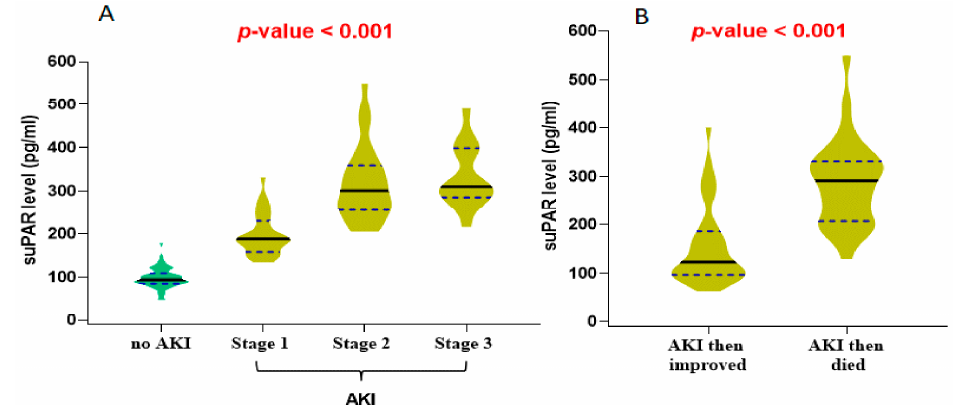
Figure 2. Violin plot for the median level of the soluble urokinase plasminogen activator receptor (suPAR) in COVID-19 patients according to ( A ) AKI stages and ( B ) prognosis of AKI. Black lines: indicate the median and blue dots indicate the 25% and 75% quartile. One-way ANOVA and unpaired t-test were used to calculate the p -value. Significance was set at p < 0.05.